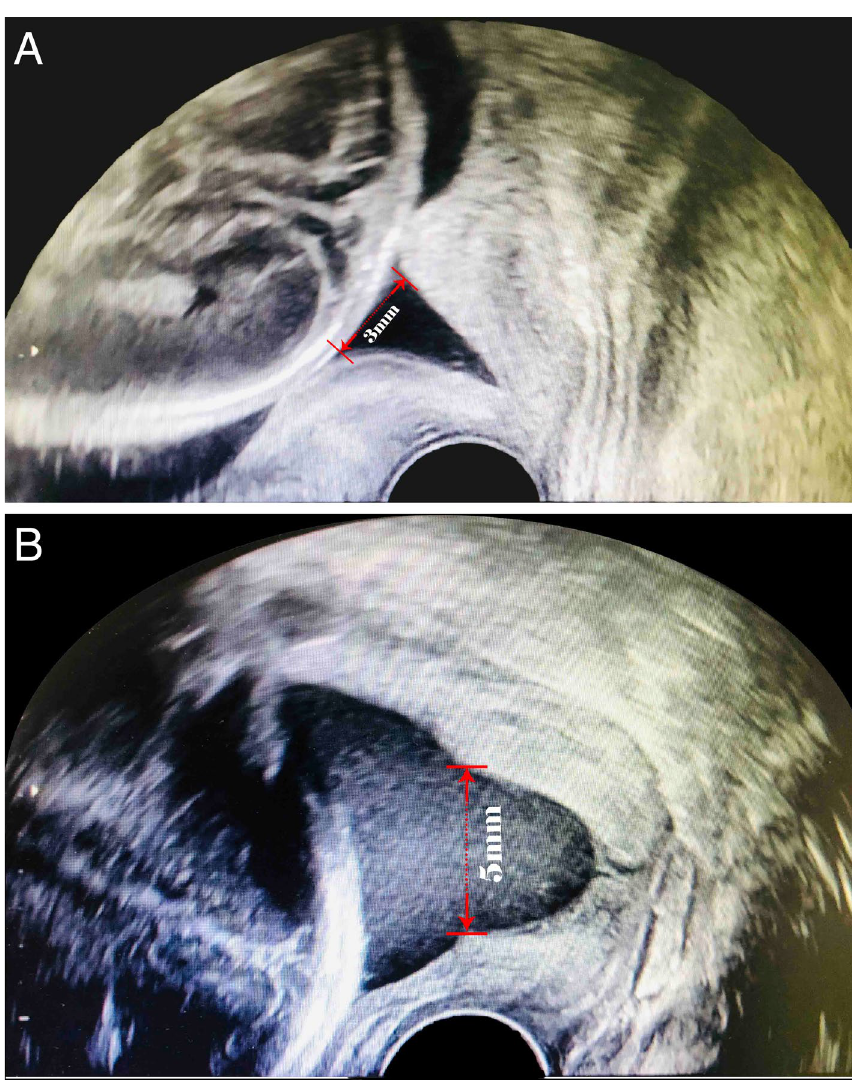
Figure 9. Cervical funneling detected by transvaginal ultrasound examination. ( A ) V-shaped funnel. ( B ) U-shaped